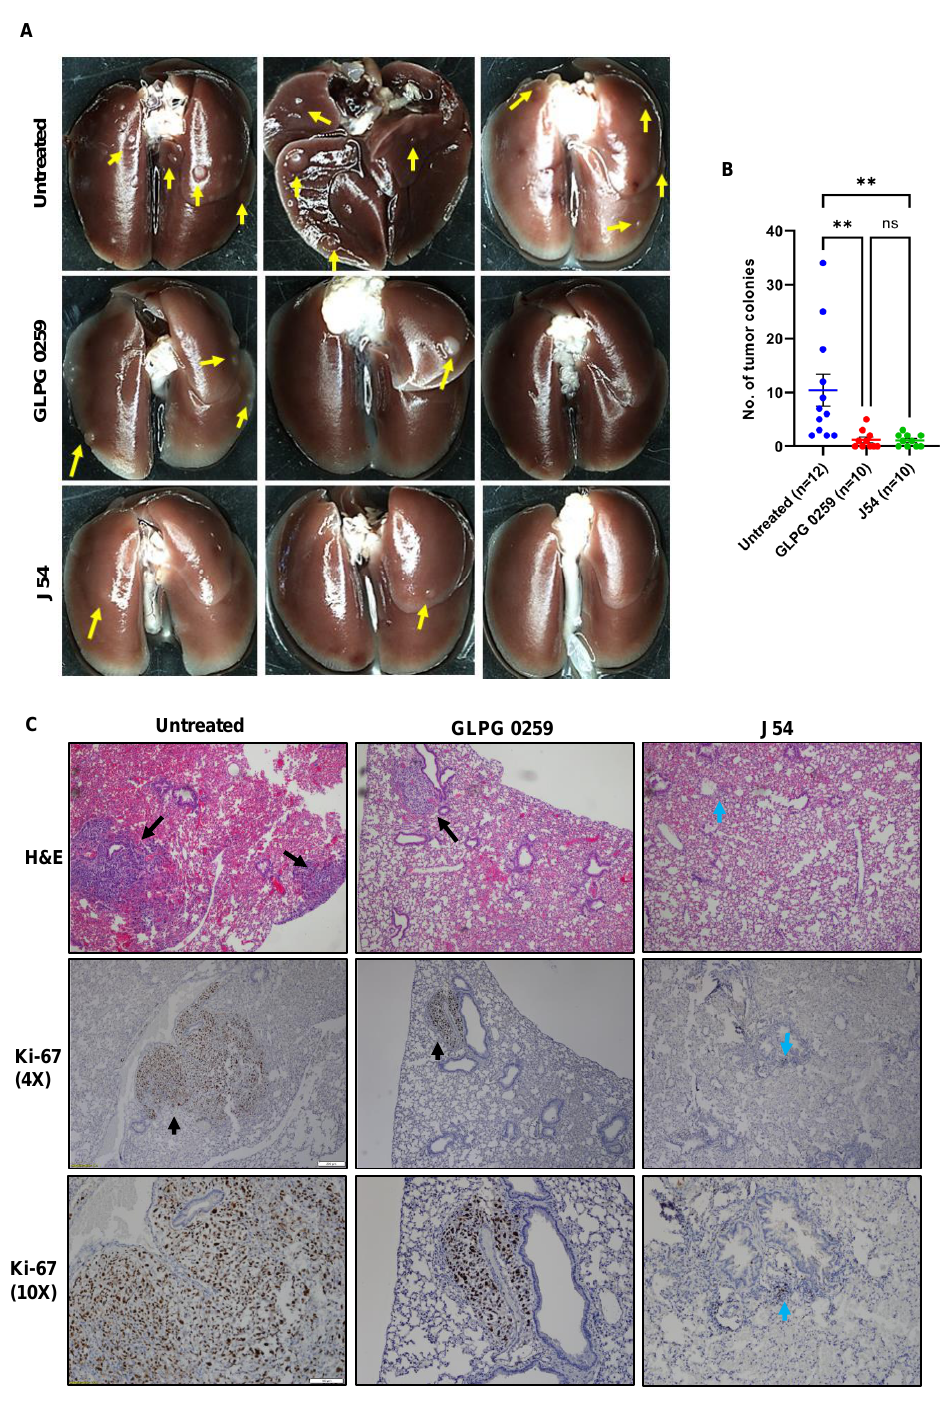
Figure 6. TLK1 or MK5 inhibition impairs lung metastasis of PC3 cells in vivo. Five-week-old SCID beige mice were injected intravenously via the tail vein with 1 × 10 6 parental PC3 cells and treated with either GLPG0259 or J54 intraperitoneally twice a week for 7 weeks. Lung metastases were compared among the untreated, GLPG-treated, or J54-treated mice. ( A ) Four representative images from each group are shown. ( B ) Data are presented as the number of metastatic colonies in the lung. ( C ) H&E and Ki-67 immunostaining shows lung nodules and proliferative tumor cells, respectively. Scale bar: 4 × = 200 µ m; 10 × = 100 µ m. One-way ANOVA, followed by Tukey’s post hoc analysis, was used for multiple group comparison: ** = p < 0.005; ns = not significant. Error bar represents standard error of the mean (SEM). The yellow and black arrows represent macroscopic nodules, whereas the blue arrows represent the presents of microscopic metastatic